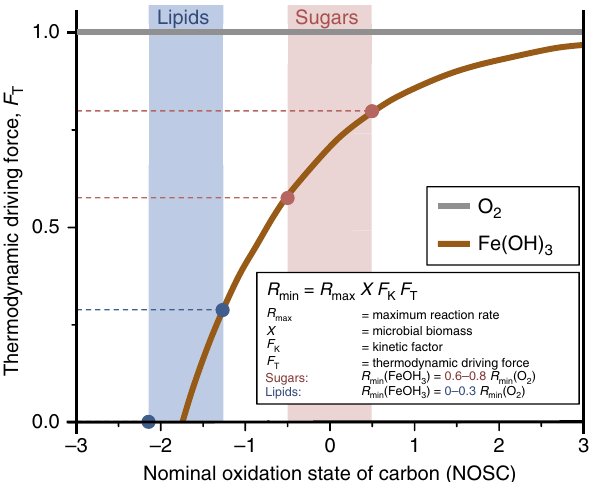
Fig. 3 Bioenergetic projections for the mineralization of organic compounds under aerobic and anaerobic conditions. The thermodynamic driving force, F T , is given for the oxidation of organic compounds spanning a range of nominal oxidation states when coupled to the reduction of oxygen (aerobic respiration) or Fe(OH) 3 (anaerobic respiration). When coupled to oxygen (gray line), F T for the oxidation of an organic compound is close to 1. Mineralization ( R min ) is thus expected to proceed uninhibited for compounds spanning the full range of oxidation states. Under Fe(OH) 3 - reducing conditions (orange line), mineralization of more oxidized compounds, such as sugars, yields projected rates comparable to those under aerobic conditions (60 – 80%). By contrast, mineralization of reduced organic compounds, such as lipids, would proceed at limited rates or may even be completely inhibited (0 – 30%), resulting in a relative enrichment, and ultimately preservation, of these abundant compound classes